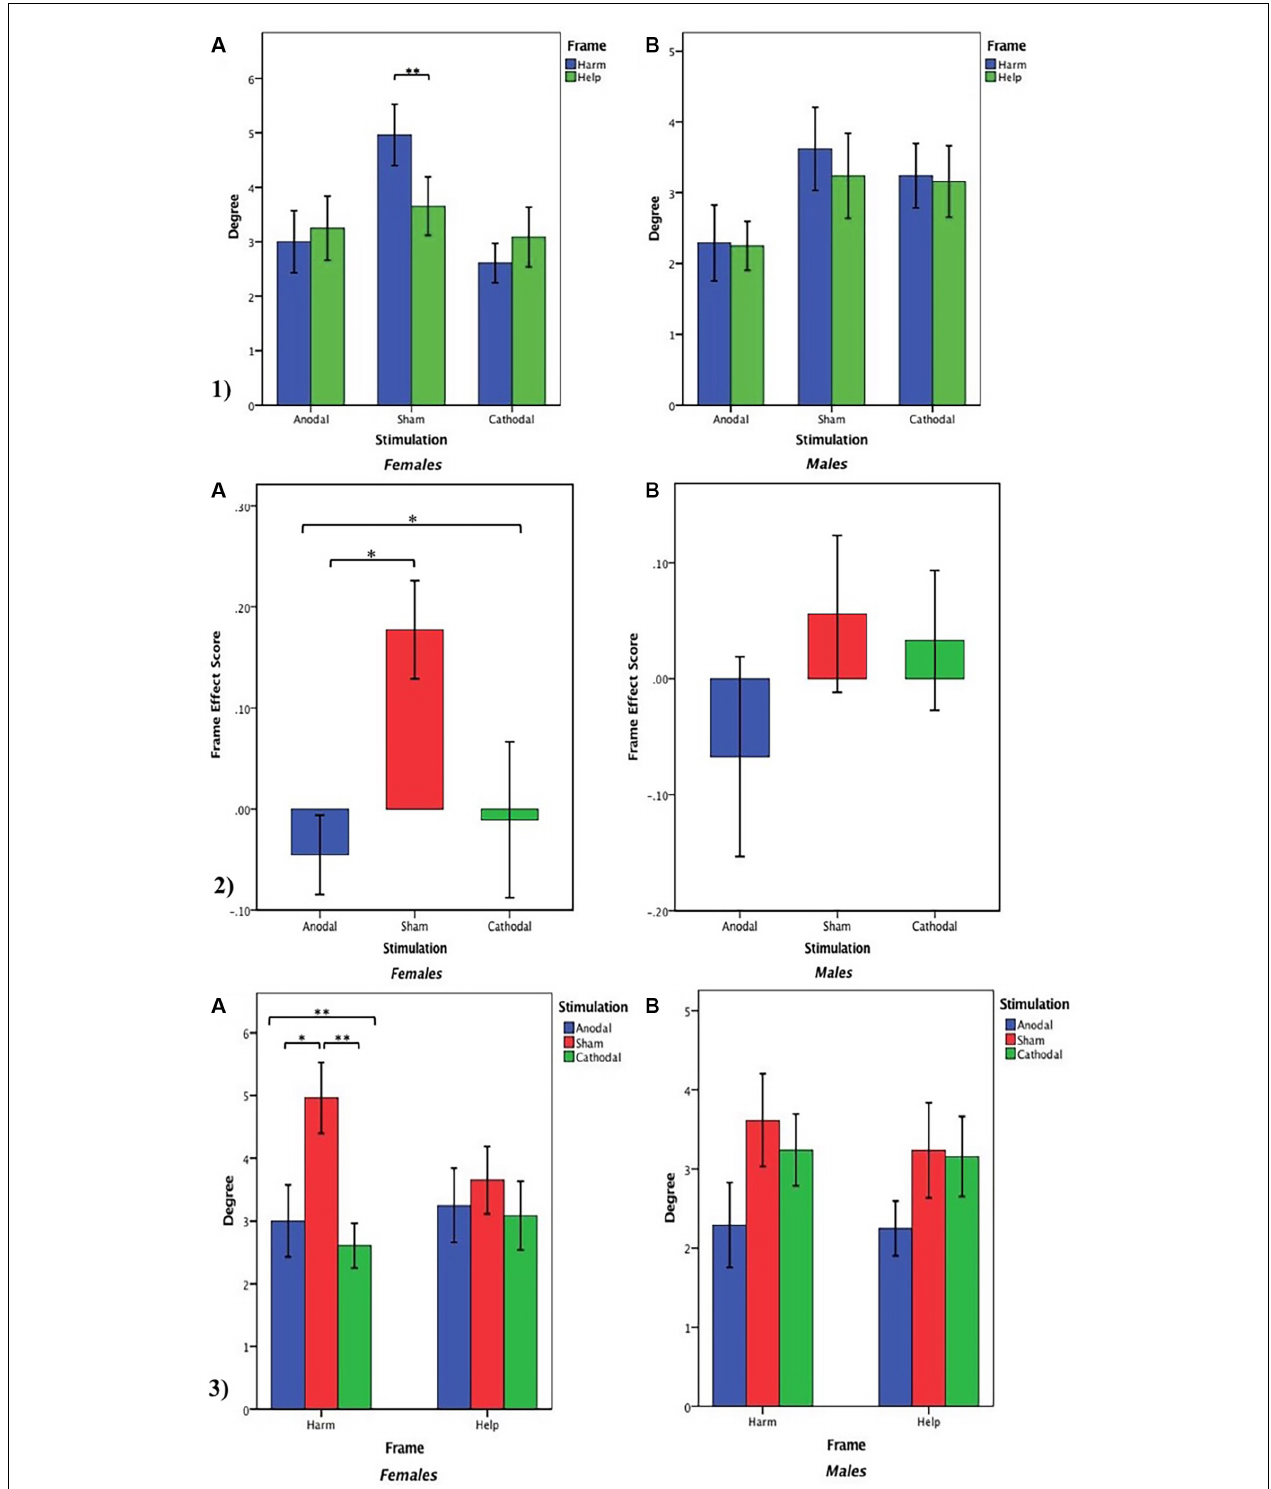
FIGURE 6 | (1) Harm degree and help degree in three stimulation conditions. (2) Frame effect score in three stimulation conditions. (3) Degree in the harm frame and the help frame across three stimulation conditions. (A) For females. (B) For males. Error bar represents standard error. Asterisks indicate a statistically significant difference between the harm degree and the help